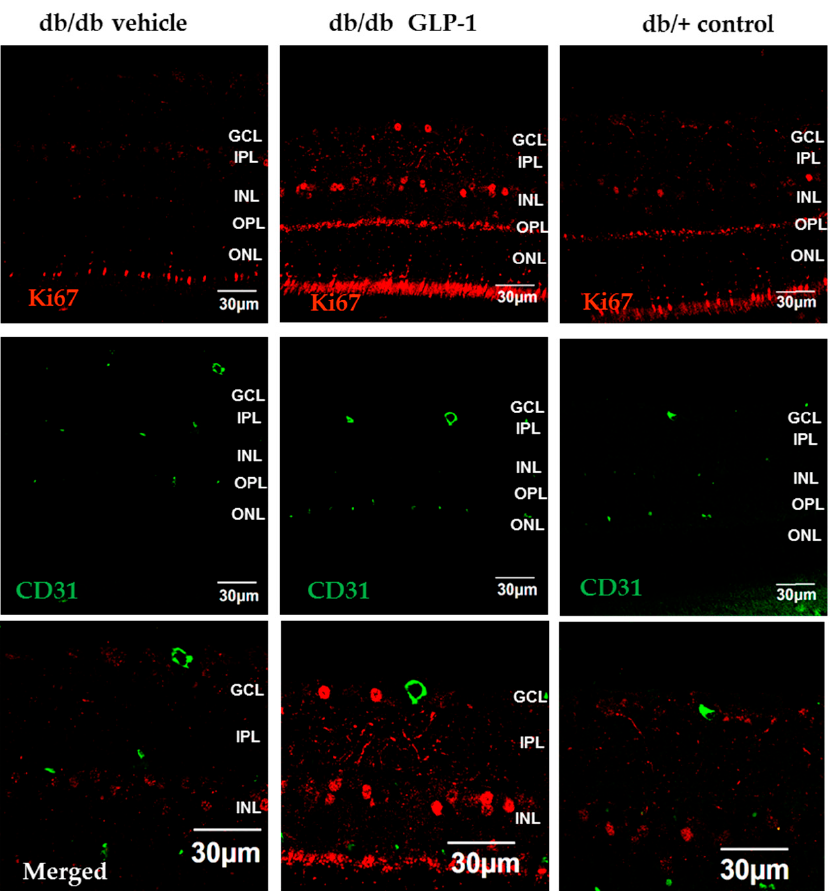
Figure 10. Ki67 (red) immunofluorescence co-labeling with CD-31 (green) in retinas of representative samples from diabetic mice treated with vehicle or glucagon-like peptide-1 (GLP-1) eye-drops, and from a non-diabetic mouse. Scale bars, 30 µm. n = 4; GCL, ganglion cell layer; INL, inner nuclear layer; IPL, inner plexiform layer; ONL, outer nuclear layer; OPL, outer plexiform layer.